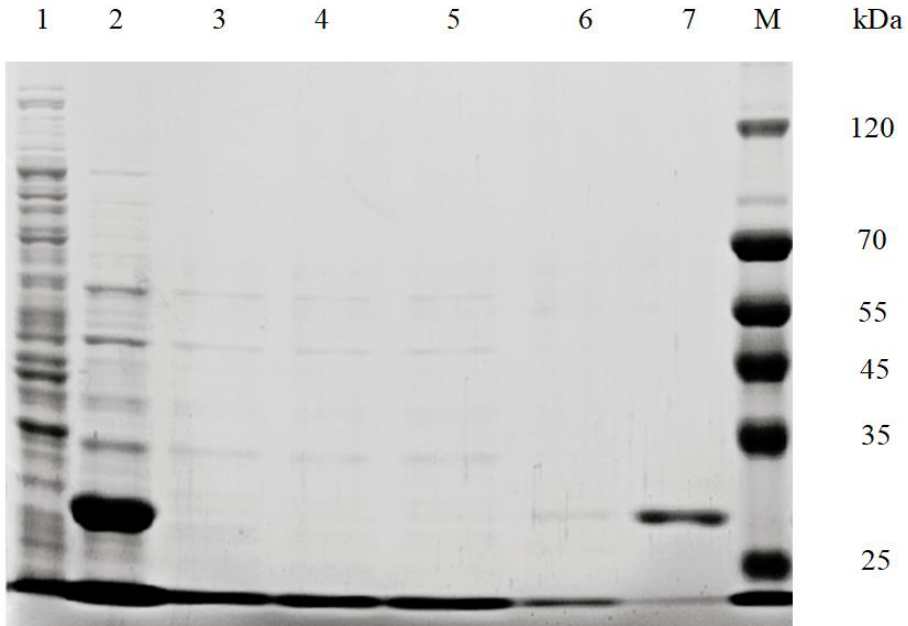
Figure 1. Cloning of ethyl carbamate hydrolase (ECH) and its overexpression in E. coli . Lane 1, E. coli BL21 (DE3); lane 2, whole cells of E. coli BL21 (DE3)/pET24b-ECH induced with IPTG; lane 3, puncture fluid; lanes 4 to 6, ECH was not eluted from a crude enzyme solution with different con- centration of imidazole (20, 100, 200 mM); lane 7, ECH was eluted from crude enzyme solution with 300 mM imidazole solution (33 kDa); lane M: protein marker.